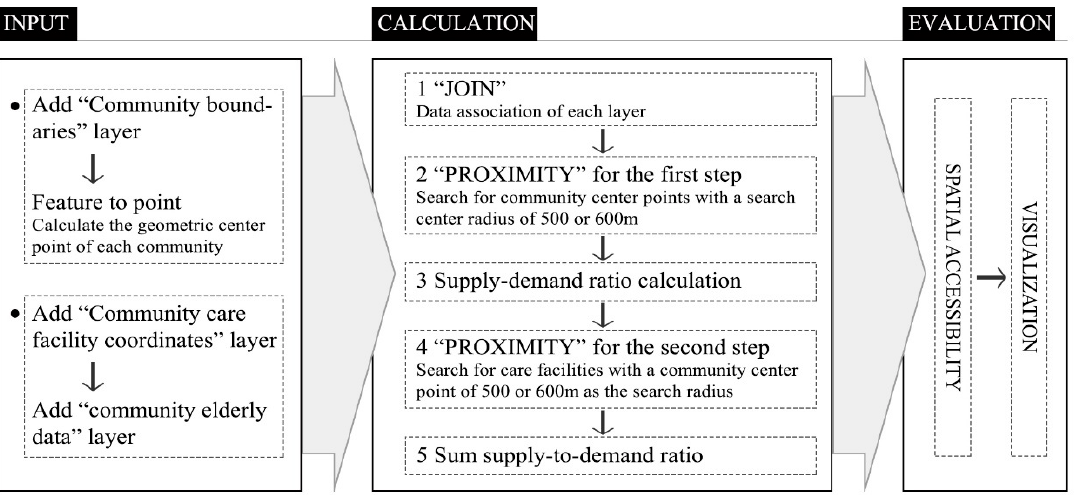
Figure 3. Implementation of the 2SFCA model in the Geographic Information System (GIS).